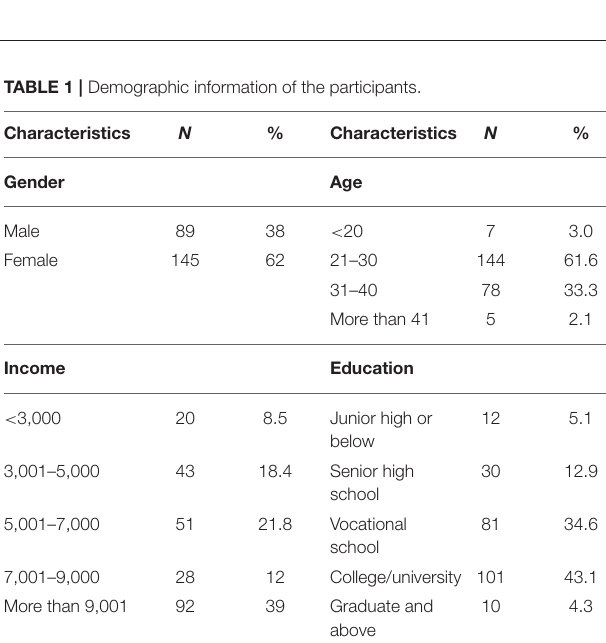
FIGURE 1 | Hypotheses model.